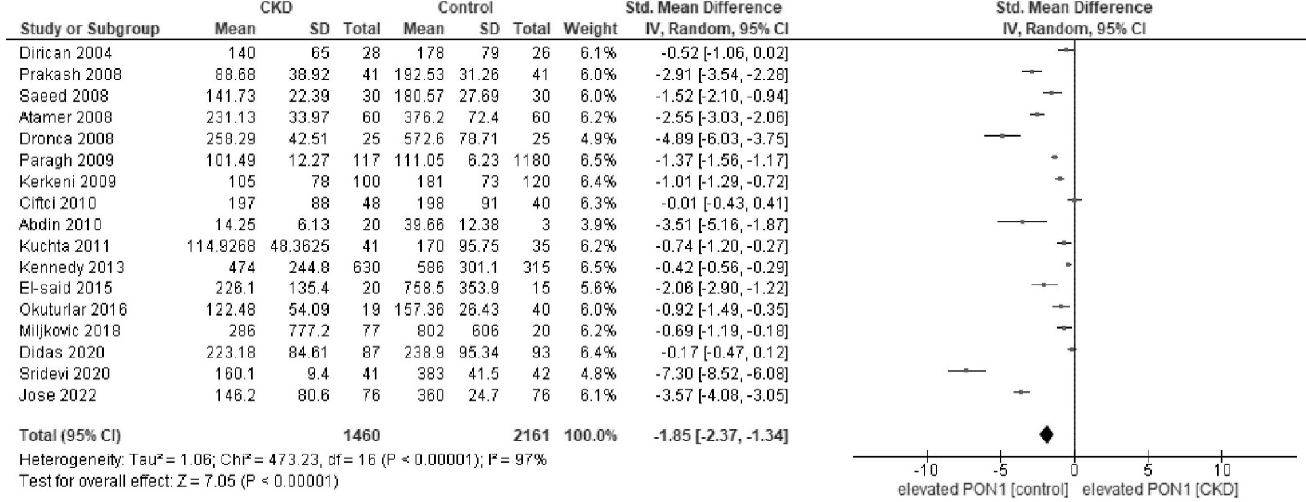
Figure A6. Forest plot of paraoxonase activity in the sensitivity analysis [26–42,44,46–49].